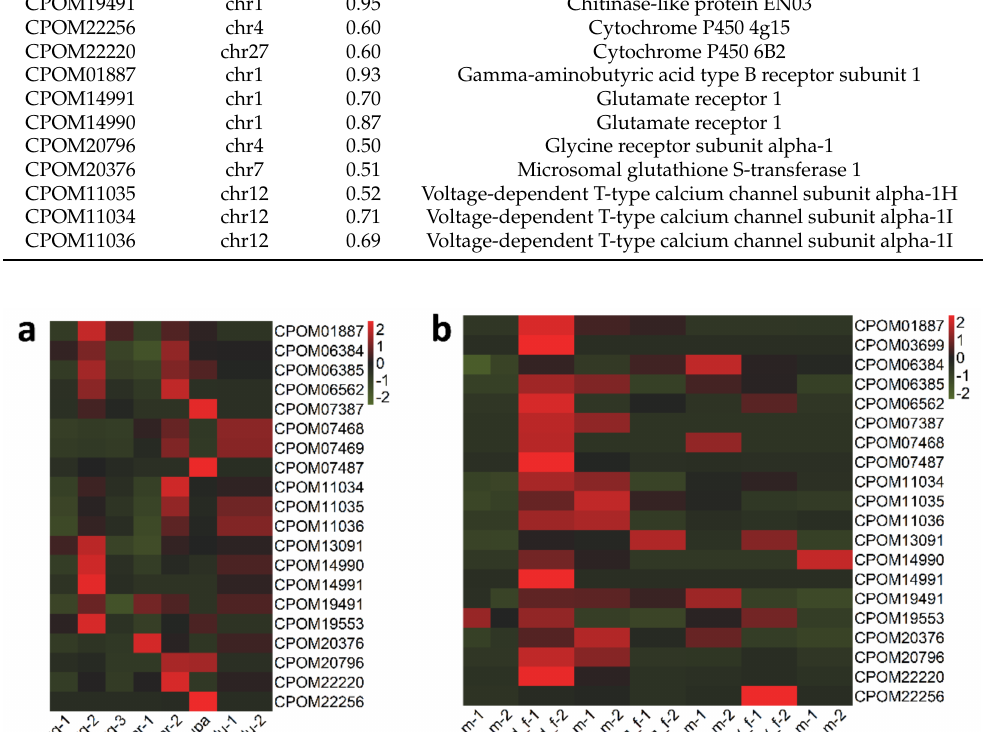
Figure 3. Expression pattern of 21 PSGs in different stages ( a ) and different tissue ( b ) of C. pomonella . The x -axis lar represents the different tissues and stages, and y -axis shows the PSGs. The color of grid represents the expression level of the PSGs in different tissues and stages. lar: larva; adu: